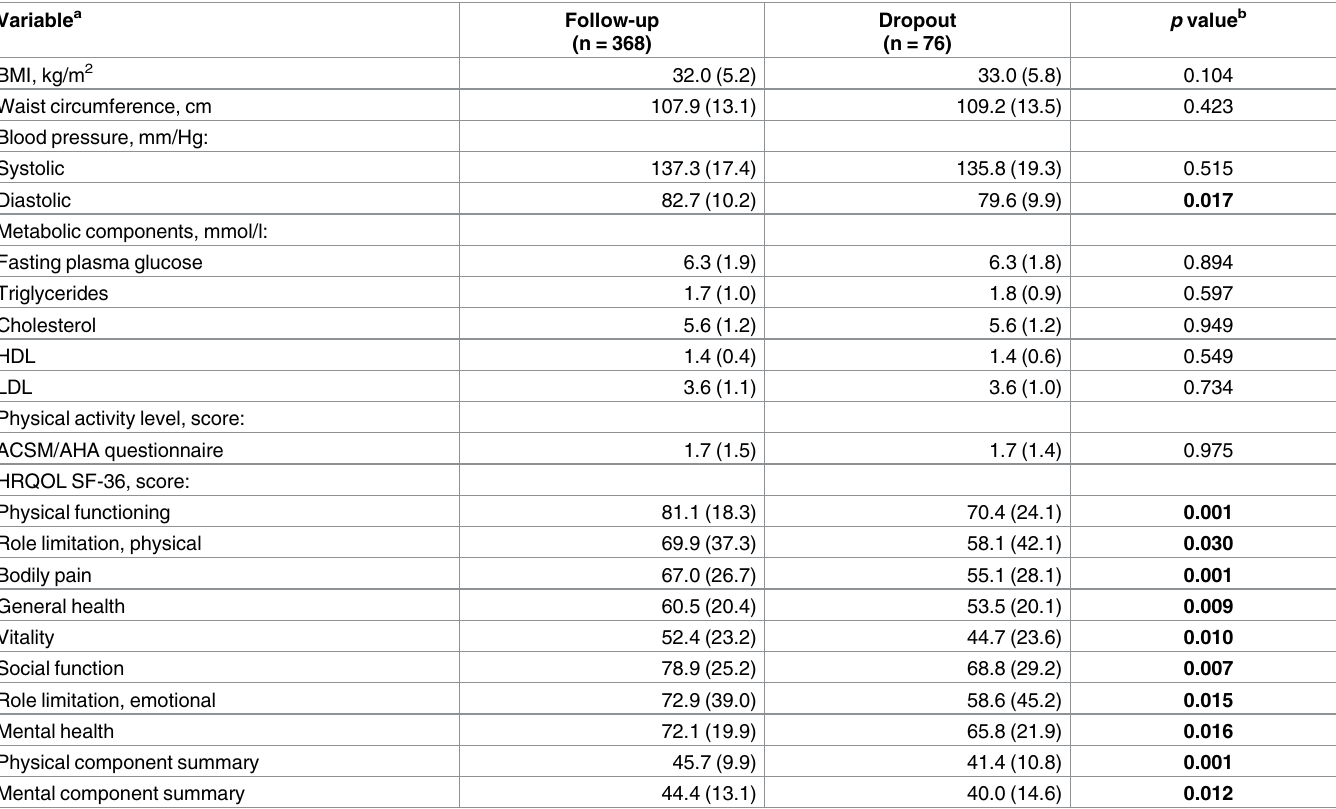
Table 2. Baseline characteristics in anthropometrics, metabolic risk factors, physical activity level and health related quality of life—Follow-up and dropout